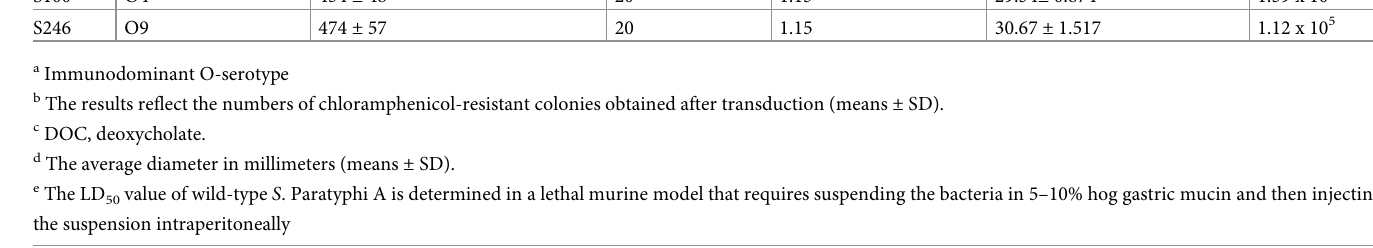
evaluated in a lethal murine model that requires suspending the bacteria in 5–10% hog gastric mucin and then injecting the suspension intraperitoneally [45]. In this model, the LD value 50 of wild-type S . Paratyphi A was approximately 100 CFU, showing a highly virulent attribute. Considering the phenotype characterizations and broad host adaption abilities, we select ST- ddhc :: prt , SE- ddhc :: abe and ST- Δ alr Δ dadB Δ recF Δ asd (pSC101- asd -O2, p15a- dadB- O9) A1 for further potential live attenuated vaccine candidates development. To guarantee their safety in the murine model, we further deleted the cya and crp global regulators of these mutant strains [46], resulting in L008 (ST- ddhc :: prt ), L009 (SE- ddhc :: abe Δ cya Δ crp ) and A1 Δ cya Δ crp Again, their O-serotype phenotypes have been reconfirmed, and the deletion mutations of cya and crp genes did not affect the O-epitopes expression (S3 Fig) but could attenuate these